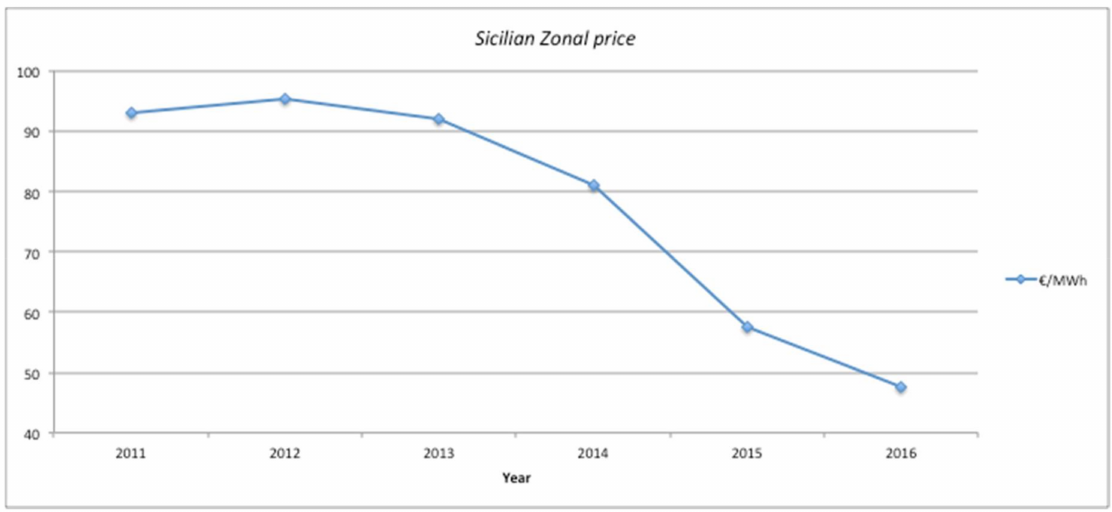
Figure 7. Sicilian electricity (zonal) price (period 2011–2016).